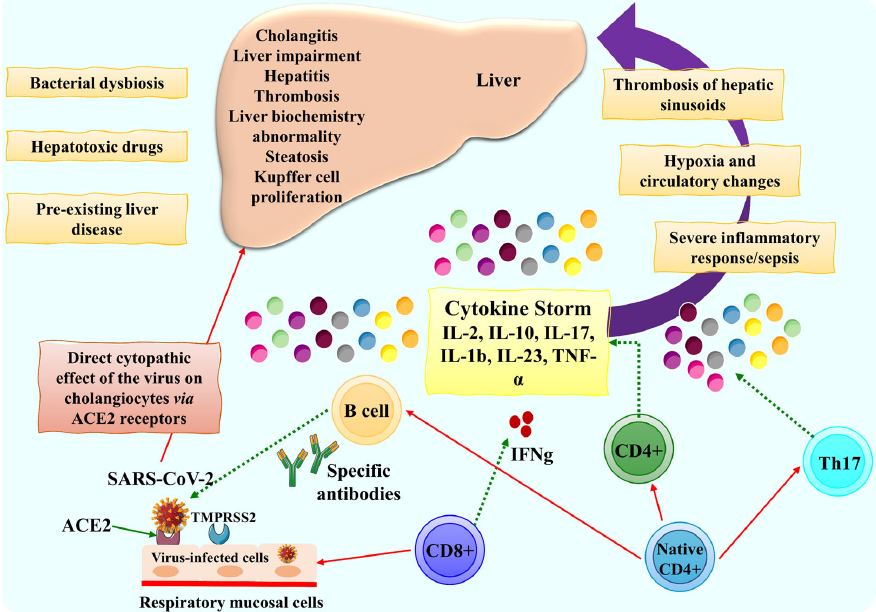
Figure 3. During a COVID ‐ 19 infection, liver dysfunction is defined by the detrimental consequences of cytokine storms (severe inflammation, thrombosis, hypoxia, and so on). Cholangitis and cytopathic effects are events that occur during COVID ‐ 19 infection as part of acute liver injury.